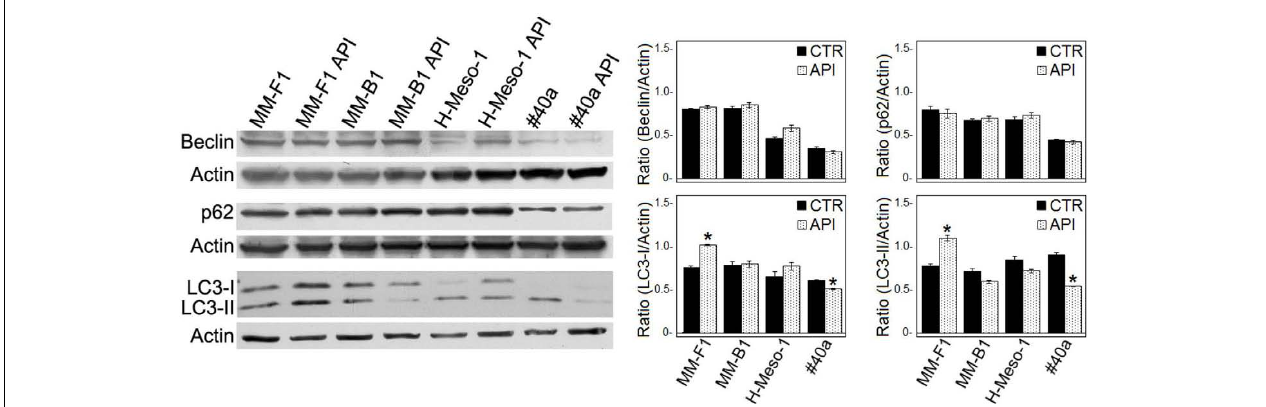
FIGURE 4 | Effect of API on the autophagic flux in MM cells. The expression of Beclin-1, p62/SQSTM (p62), and LC3-I and LC3-II was assessed by Western blotting in MM cell lines treated with API at 50 µ M or DMSO (CTR) for 24 h. Actin was used as an internal control. The intensity of the bands obtained was quantified using the ImageJ software after blot scanning of two independent experiments. The densitometric ratios between Beclin-1 and actin, LC3-I and actin, LC3-II and actin, p62 and actin and statistical analysis are reported. Data are expressed as the mean ± SD of two independent experiments ( ∗ p ≤ 0.01 compared with CTR).